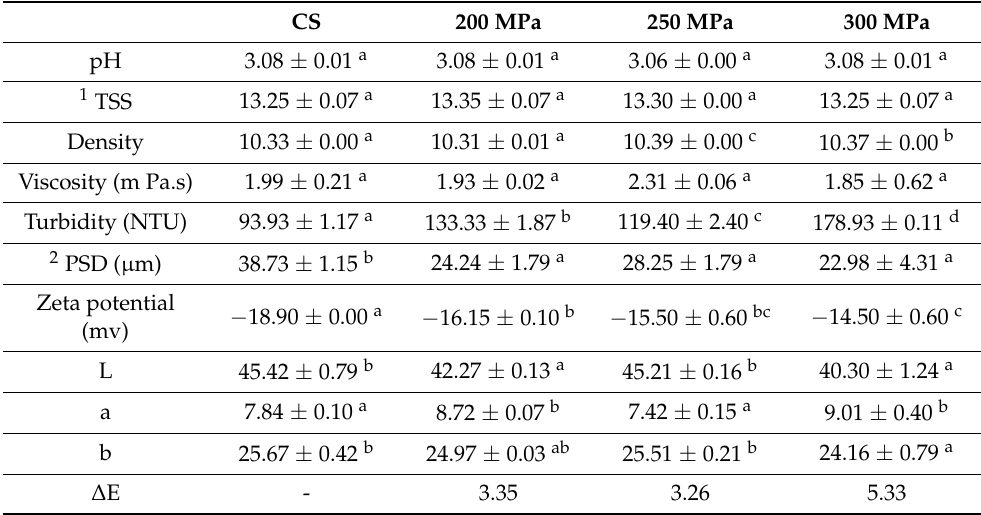
Table 1. The physicochemical properties of apple juice treated via HPH